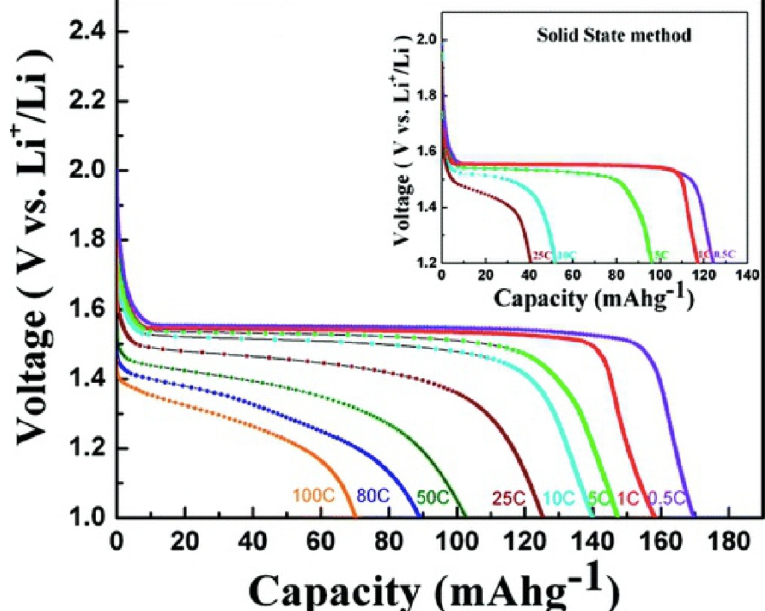
Figure 8. Capacity-voltage profile for nanocrystalline Li 4 Ti 5 O 12 (SEM images in Figure 7) synthesized by the combustion method at different C -rates. Inset shows capacity voltage profile for bulk Li 4 Ti 5 O 12 prepared by the solid-state method. Reproduced with permission from [108]. Copyright Elsevier,